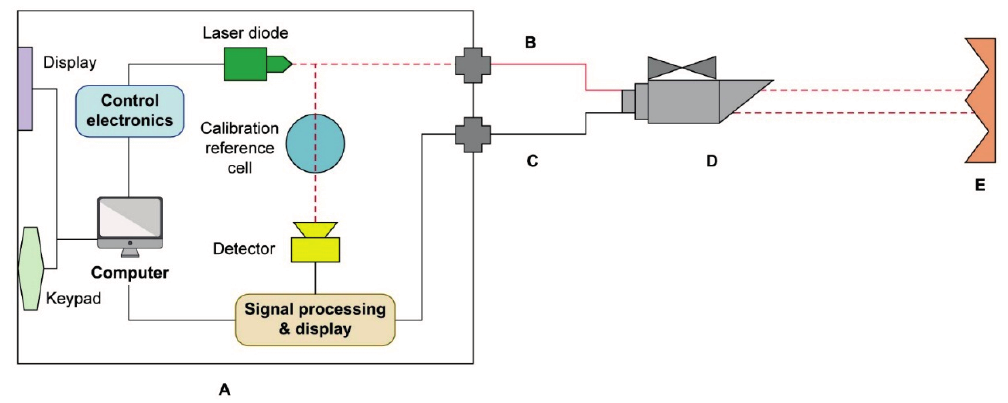
Figure 2. Schematic representation of the OP-laser components. ( A ) open-path gas monitor; ( B ) fiber-optical cable; ( C ) co-axial cable; ( D ) remote head; and ( E ) retro-reflector.